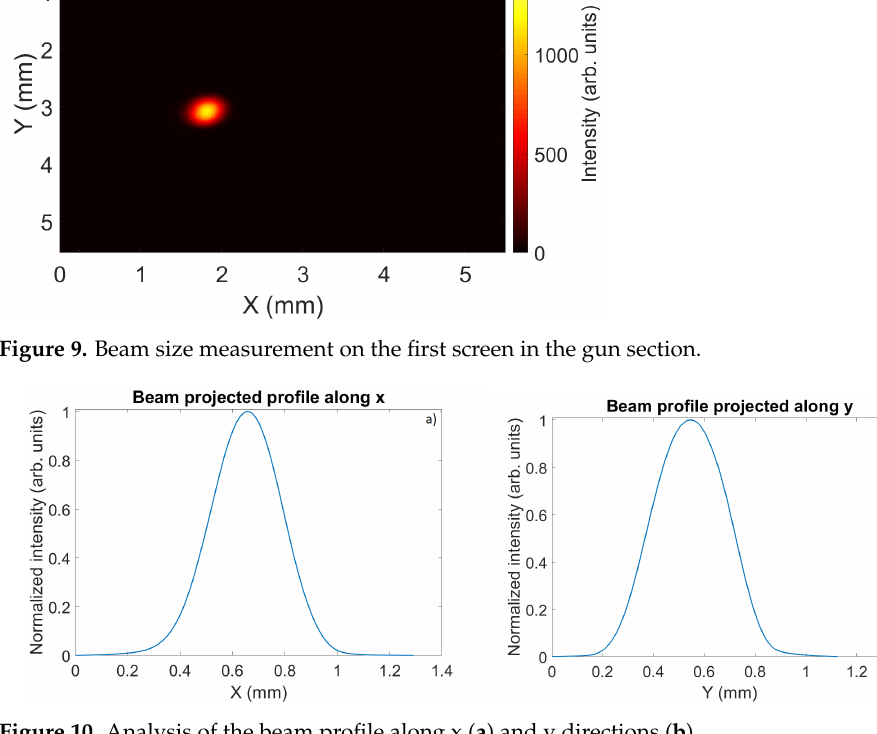
Figure 10. Analysis of the beam profile along x ( a ) and y directions ( b